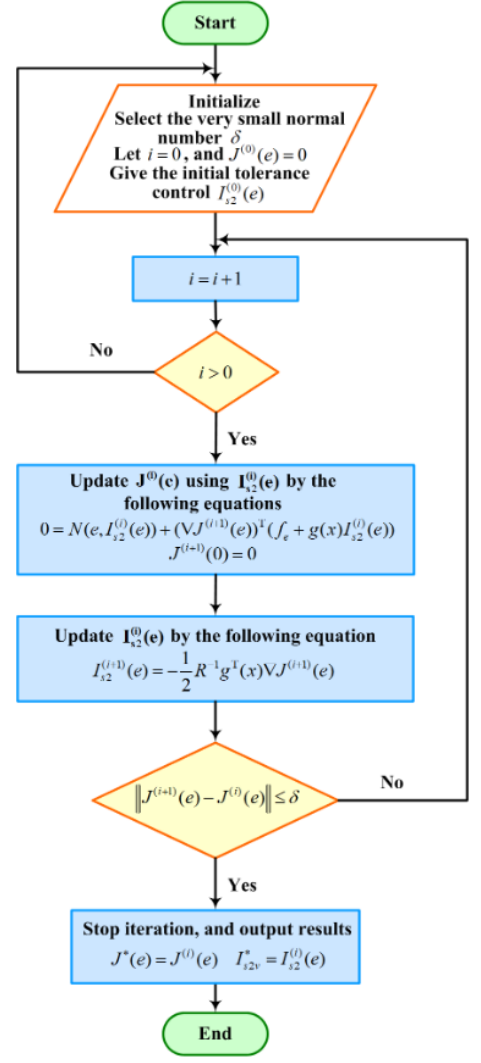
Figure 5. Flowchart of critic-only policy iteration algorithm.